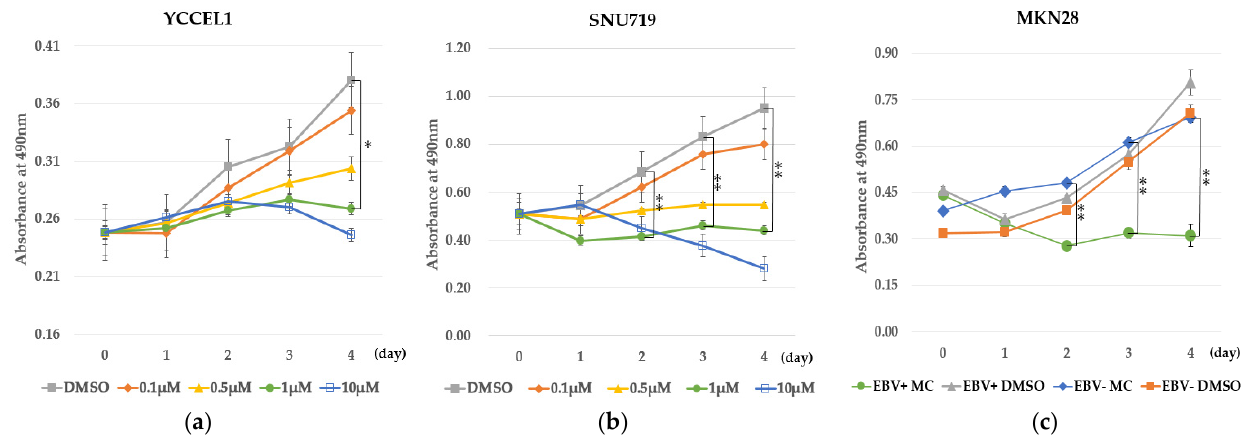
Figure 1. MC180295 inhibits cell growth in EBV-positive gastric cancer cells. ( a ) The inhibition of cell growth of YCCEL1 by MC180295 was significant at 4 days after exposure to 1 µ M MC180295. ( b ) The inhibition of cell growth of SNU719 by MC180295 was significant at 2 to 4 days after exposure to 1 µ M MC180295. ( c ) EBV-positive MKN28 cells showed marked growth inhibition by 1 µ M MC180295, compared to EBV-uninfected MKN28 cells and controls treated with DMSO. The y-axis